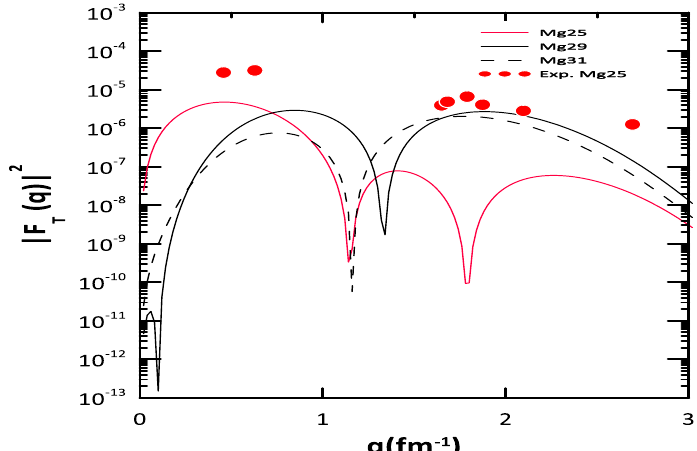
Fig. 10: The relation between moment transfer and transverses form factor for 25,29,31 Mg nuclei.